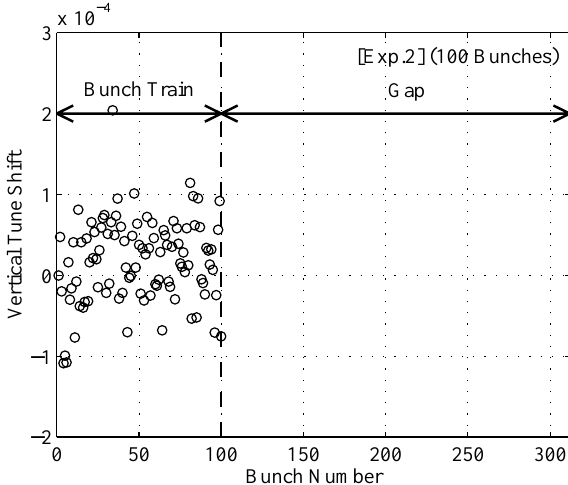
FIG. 3. Spectrum of the 20th bunch in the bunch train at f shutter 1 qf rev .